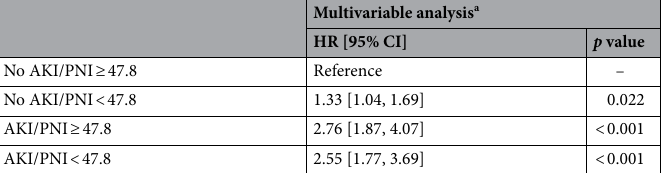
Table 4. Cox regression analysis for mortality groups by AKI/PNI. a Adjusted with age, sex, diabetes mellitus, hypertension, smoking, body mass index, hemoglobin, RDW-CV, eGFR, uric acid, CRP, proteinuria, AKI, medication usage at discharge such as statin and angiotensin II receptor blocker (ARB)/angiotensin converting enzyme inhibitor (ACEI). HR hazard ratio, CI confidence interval, AKI acute kidney injury, PNI prognostic nutritional